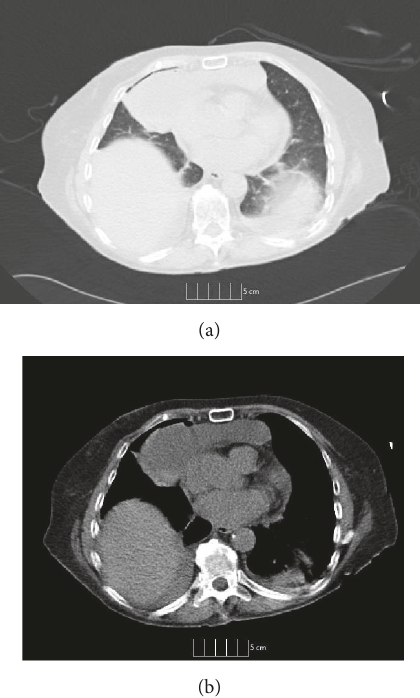
Figure 2: Cystic lesion in the mediastinum on (a) noncontrast CT lung window and (b) noncontrast CT of the